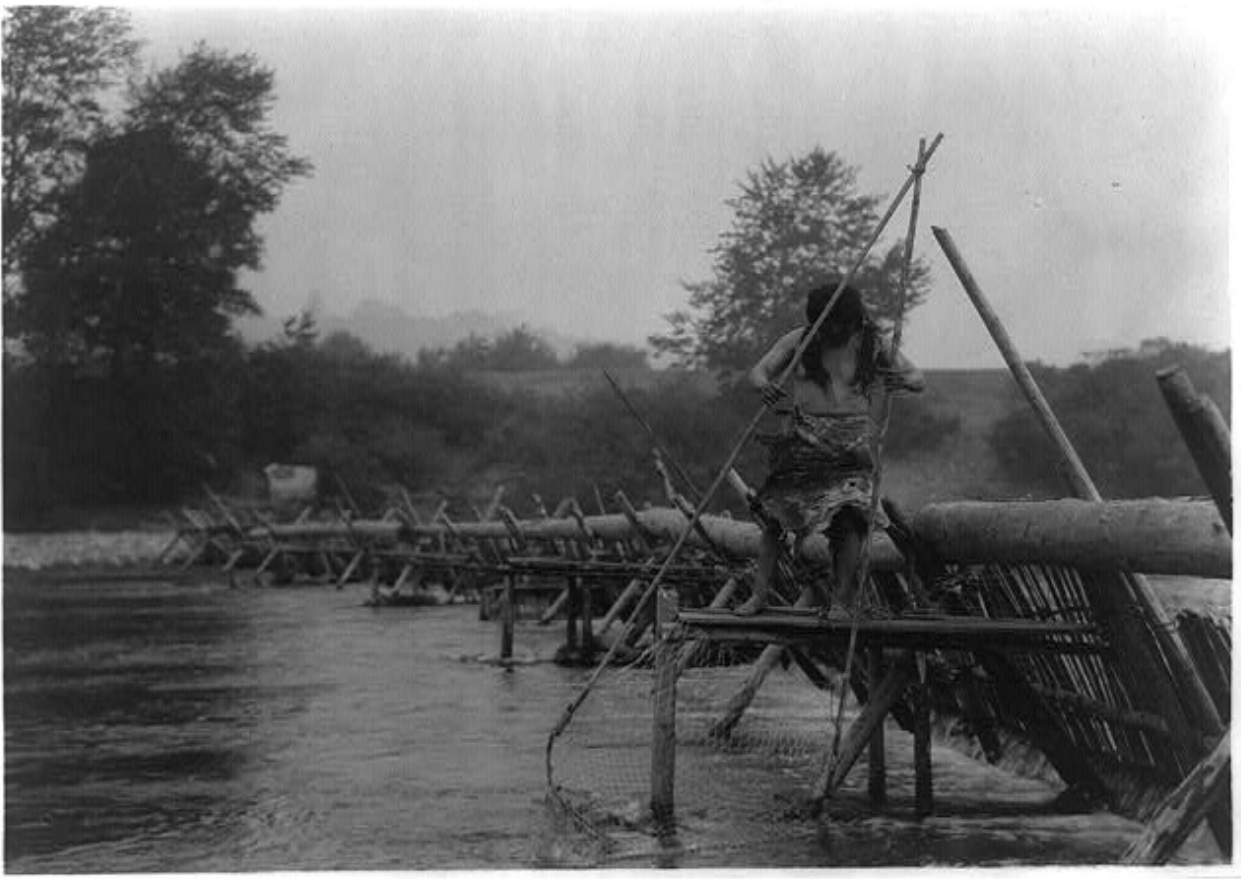
Fig. 3. Indian Fish Weir. Source: Library of Congress, Prints & Photographs Division, Edward S. Curtis Collection [reproduction number: